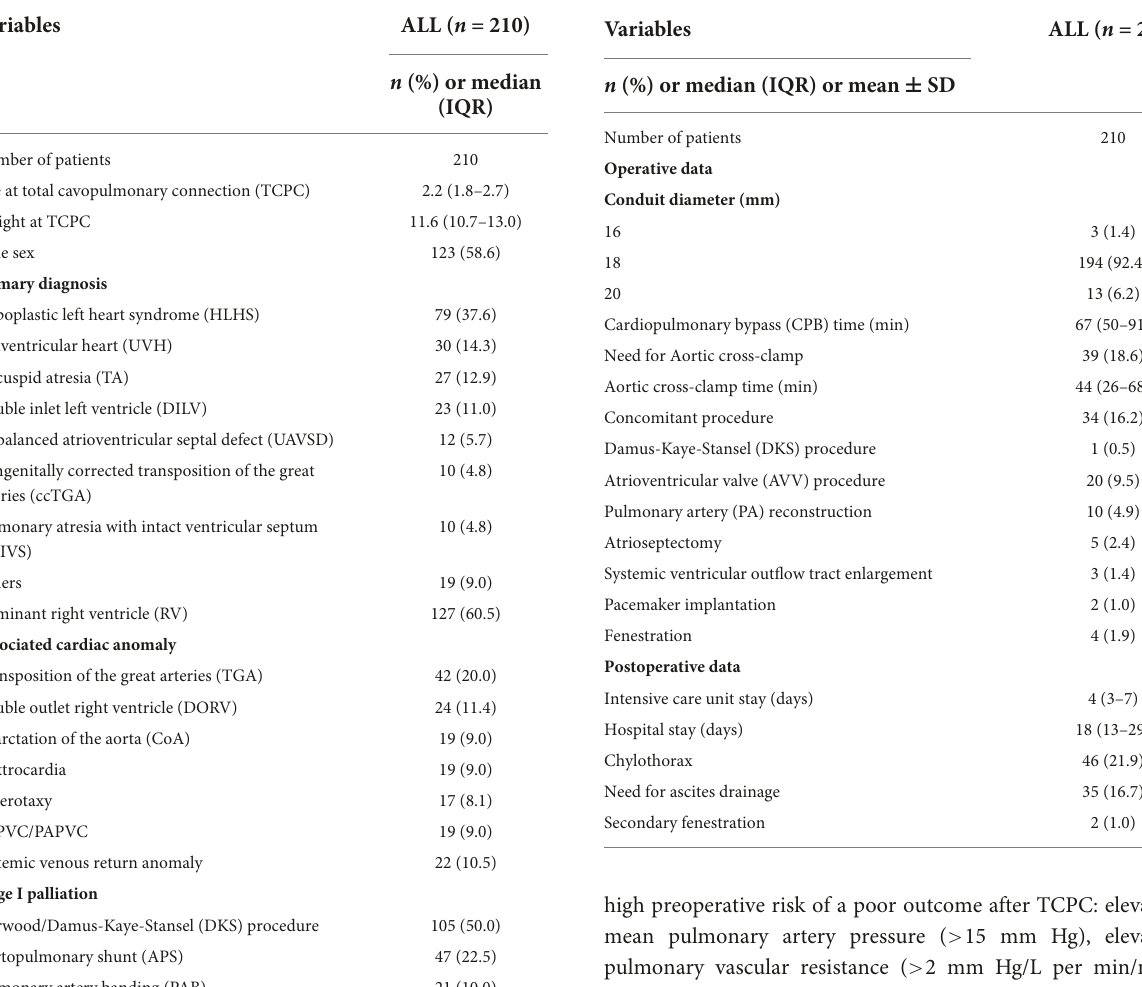
TABLE 1 Patient